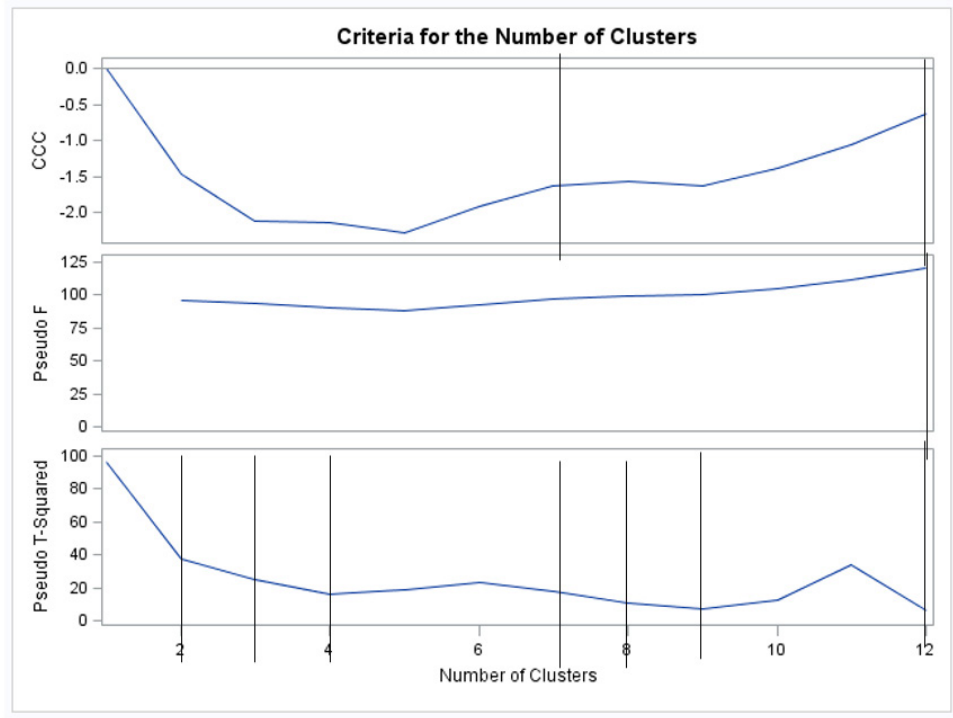
Figure 6. Graphs returned using the ACECLUS analysis for determining the number of clusters to use. Vertical lines were added by the author for demonstration purposes. This example uses principal components for the blade profile and shows a likely number of 7 significant